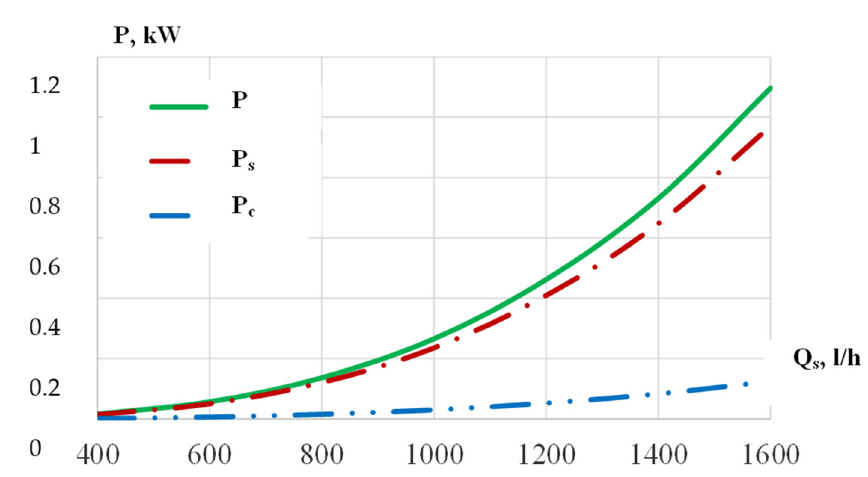
Figure 4. Dependence of the capacity of the cream, skim milk supply pumps and the total capacity of the JSHMSSFP Pc, Ps, and P on the supply of skim milk Qs (at d k = 3 mm; µ k = 0.95; F n = 3.5%; F s = 0.05%; F c = 40%; h = 0.6 mm; µ B = 0.3).